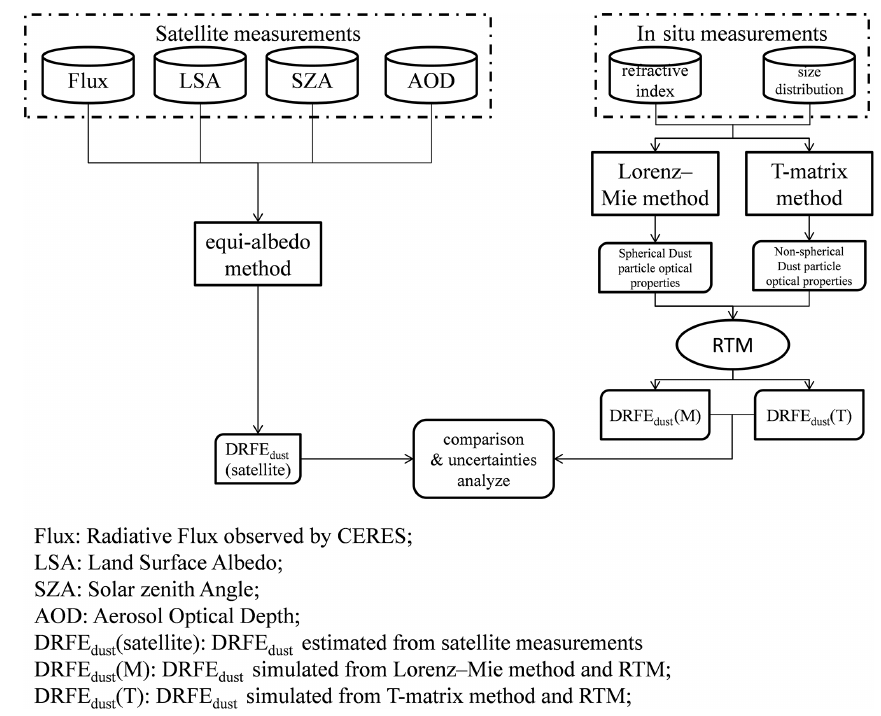
Figure 1. Processing flow chart of this